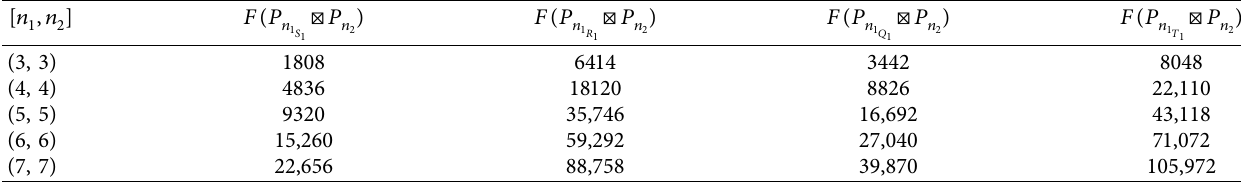
-sum path graphs. 1